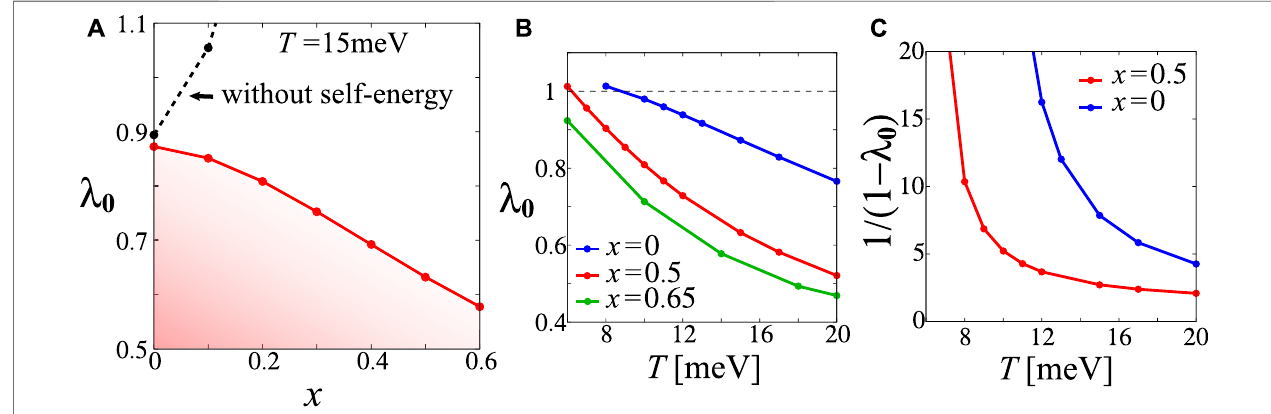
FIGURE 7 | (A) x dependences of λ 0 in the DW equation with and without self-energy at T = 15 meV. (B) T dependences of λ 0 with self-energy for x = 0, 0.5, 0.65. (C) T dependences of 1/(1 − λ 0 ) with self-energy for x = 0, 0.5.